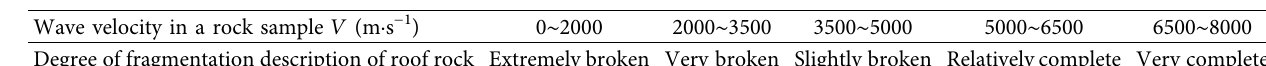
Table 2: Wave speed and damage degree of rockmass.